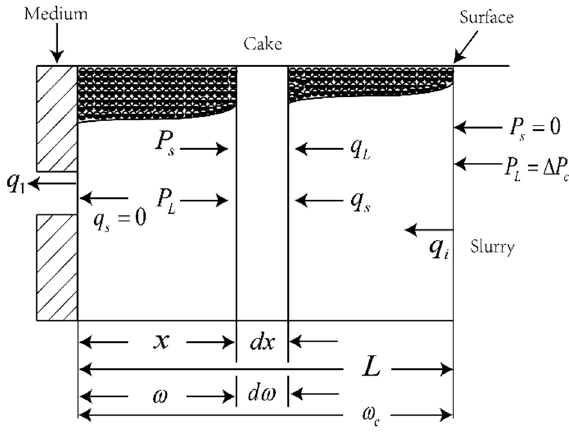
Figure 1. Schematic diagram of the conventional slurry infiltration process (adapted from [2]).